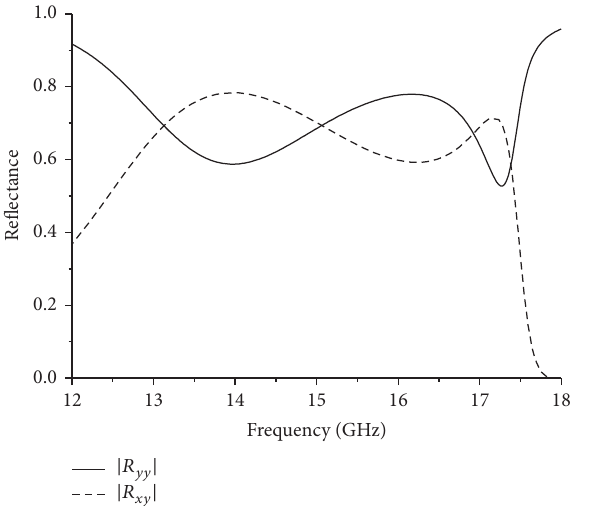
Figure 10: The simulated reflectance of the broadband circular polarizer.